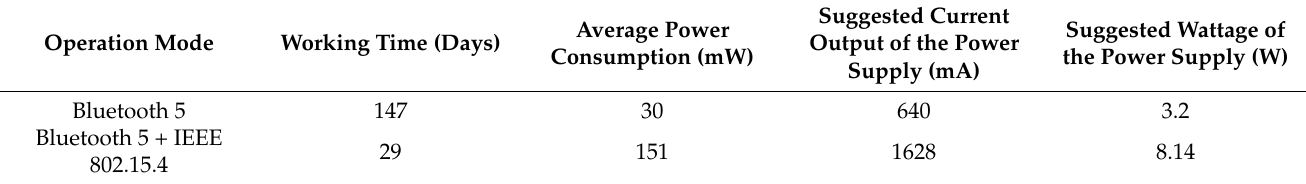
Table 1. Energy consumption parameters of the standards of the